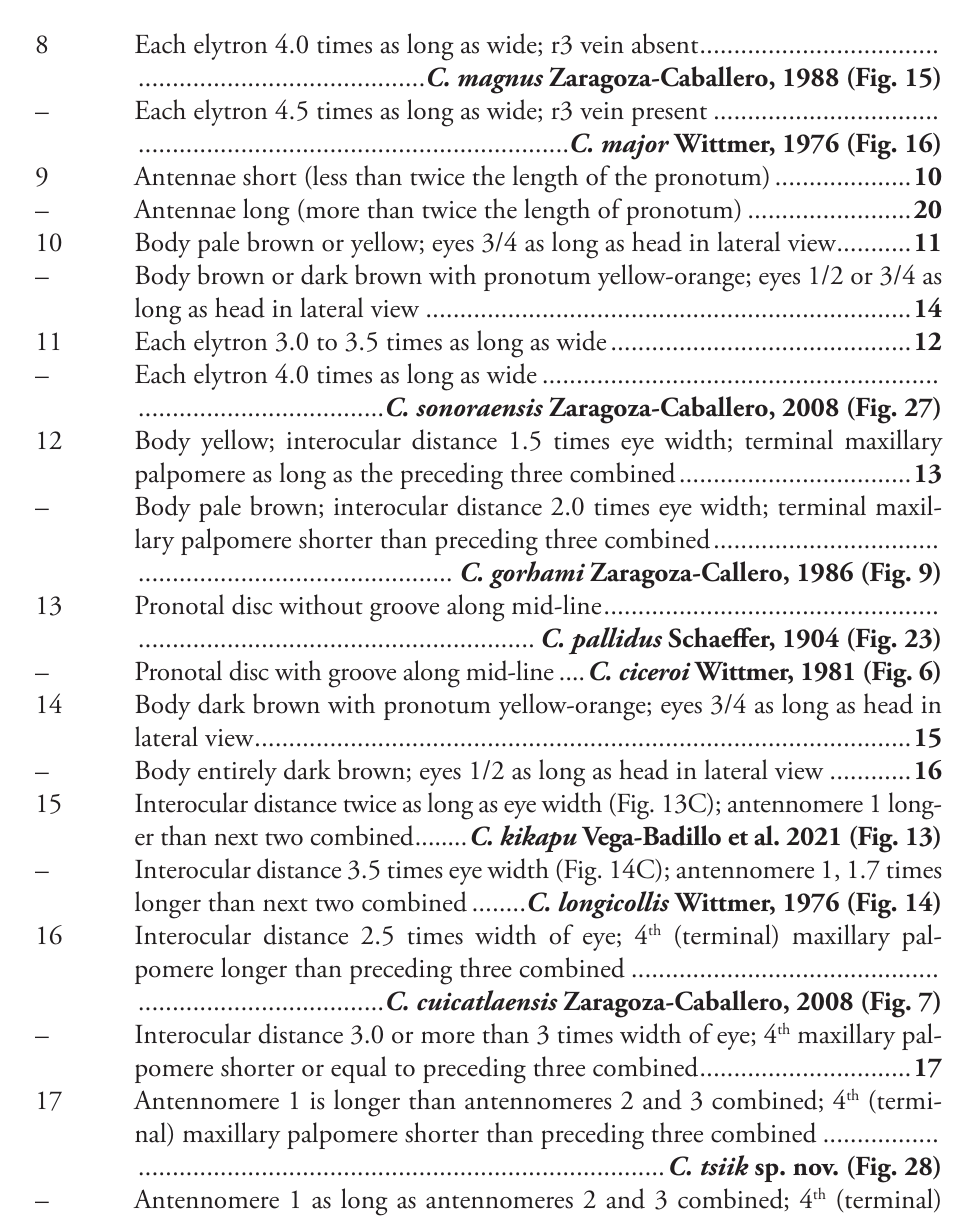
– Antennomere 1 as long as antennomeres 2 and 3 combined; 4 th (terminal)